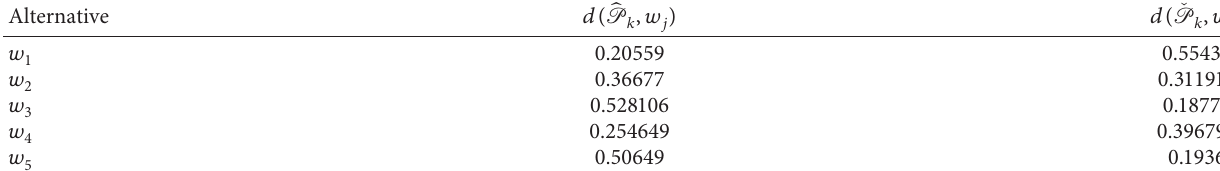
Table 35: Tabular representation of normalized Euclidean distance from ideal solution.